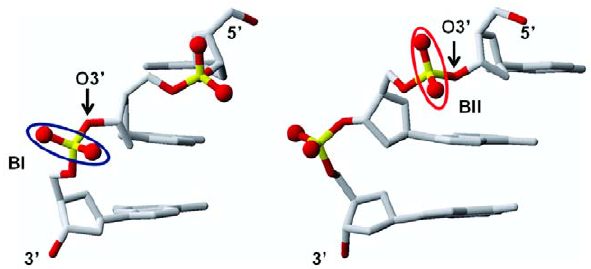
Figure 2. BI and BII phosphate groups . The two panels represent two views of the same 5 9 -CpApG-3 9 fragment and highlight the structural differences between BI (p in GpA, circled in blue in the left panel) and BII (p in CpA, circled in red in the right panel) phosphate groups. The orientation of the O1P-O2P vector is roughly perpendicular and parallel to the axis of the double helix in BI and BII, respectively. The O3 9 atom points outside the helix in BI whereas it is turned towards the helix center in